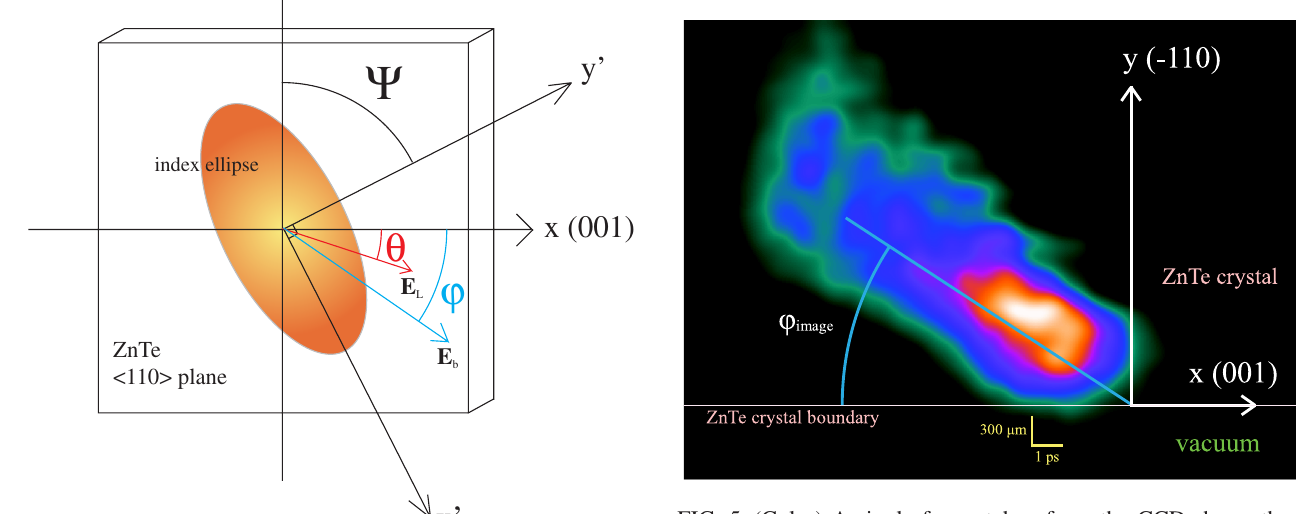
FIG. 5. (Color) A single frame taken from the CCD shows the background-subtracted modulated laser pulse. The temporal FIG. 4. (Color) Index ellipsoid projection onto the 110 face of information is encoded onto the horizontal axis and the vertical ~E the ZnTe crystal showing the angles of the beam electric field axis is related to the propagation of the beam field in the b ~E and of the laser electric field material. L